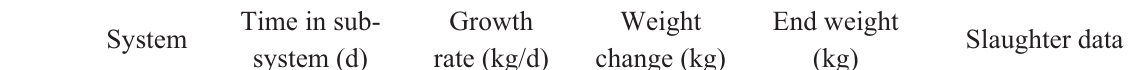
Table 1. Mean production data for sub-classes of growing and finishing animals within three beef production systems: conventional (CON), natural (NAT) or grass-fed (GFD) a